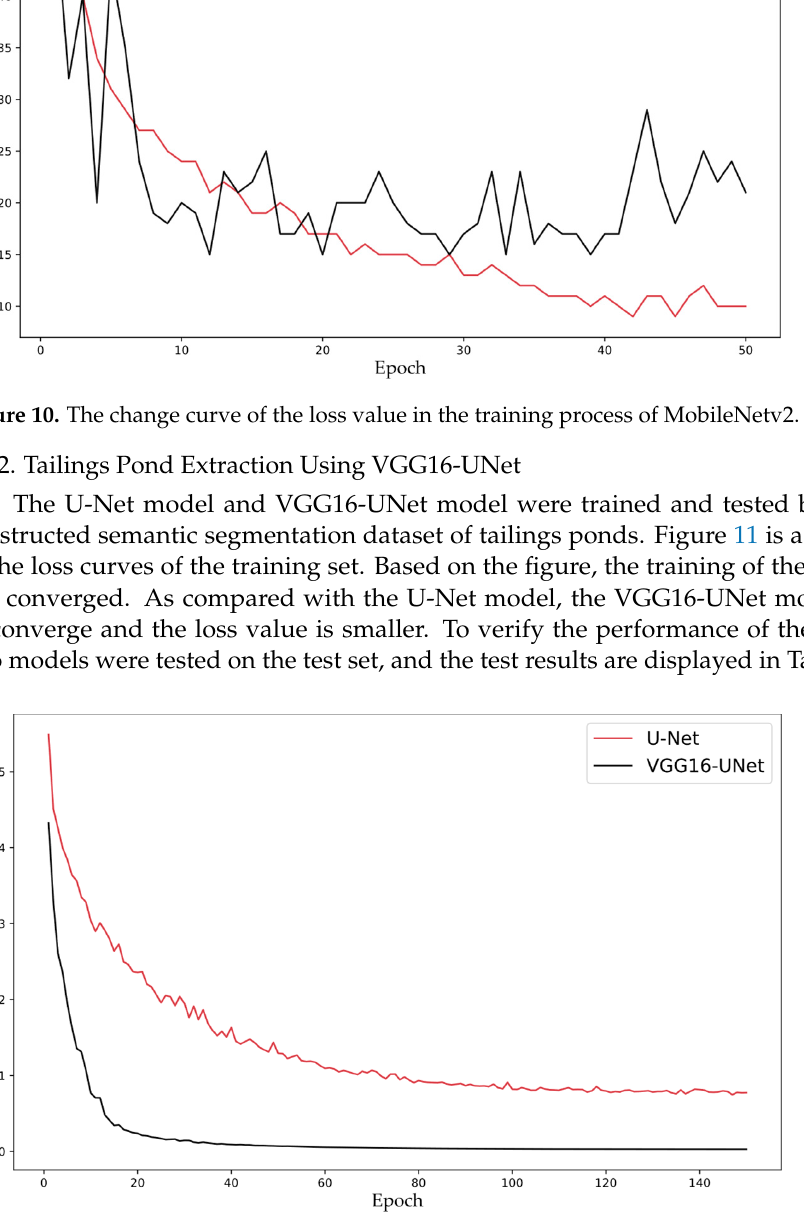
Figure 11. The change curve of the training set loss value in the training process of the U-Net model and VGG16-UNet model. Table 2. Comparison of the test set’s evaluation metrics for the two models.